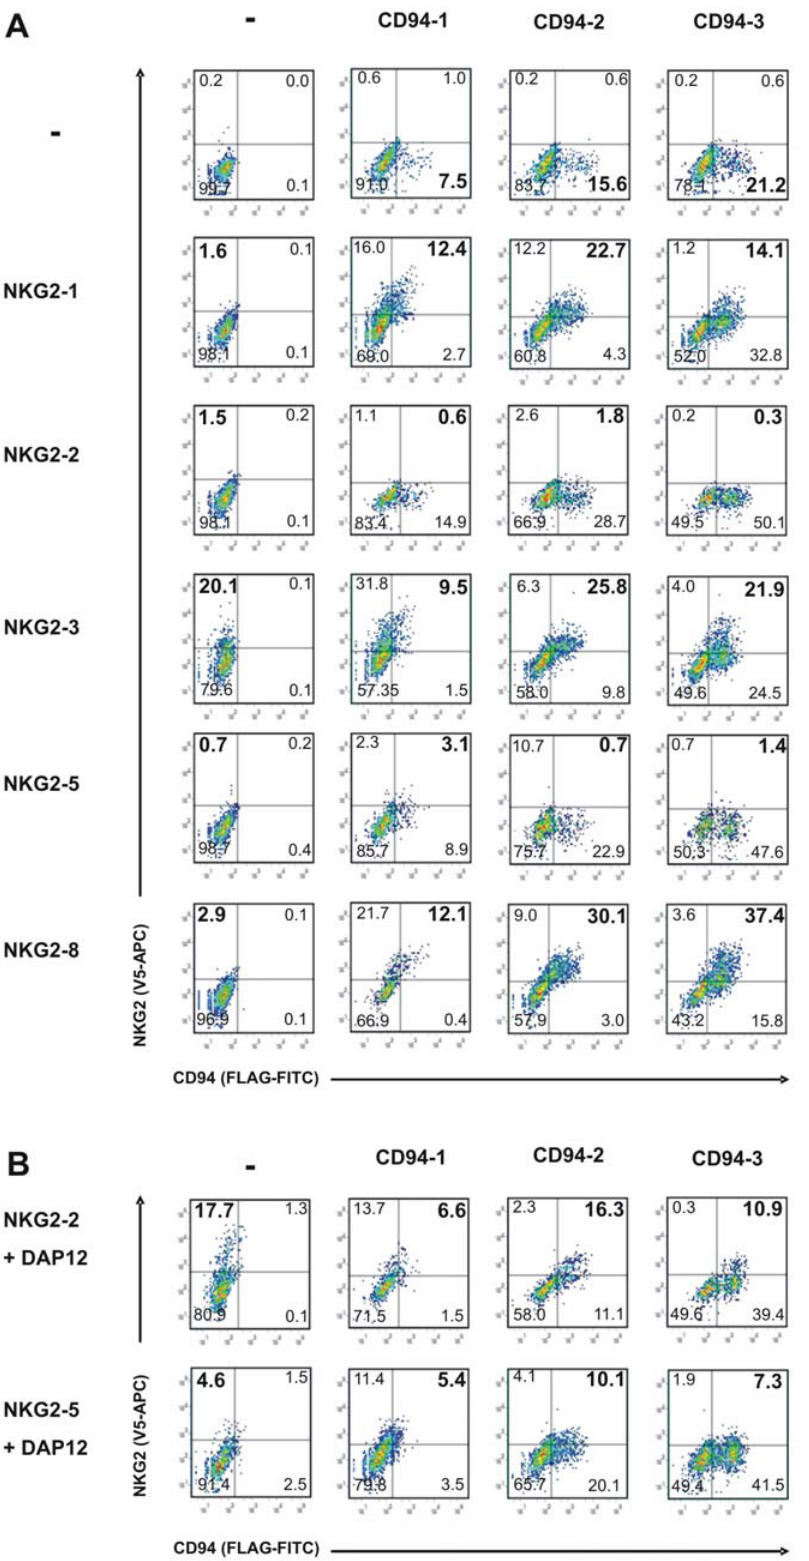
Figure 7. COOH terminally tagged NKG2 (V5 tag) andCD94 (FLAG tag) molecules were transiently transfected into 293T cells. Analyses were performed 24 h upon transfection. Representativesof at least three independent experiments areshown. Numbers indicate thepercentage of cells in each quadrant. Cells in the upper right quadrant show V5- and FLAG-double-positive cells. (A) CD94 and NKG2 cell surface expression without co- expression of DAP12. (B) Enhancement of NKG2-2 and NKG2-5 expression at the cell surface by co-expression of myc-tagged DAP12.